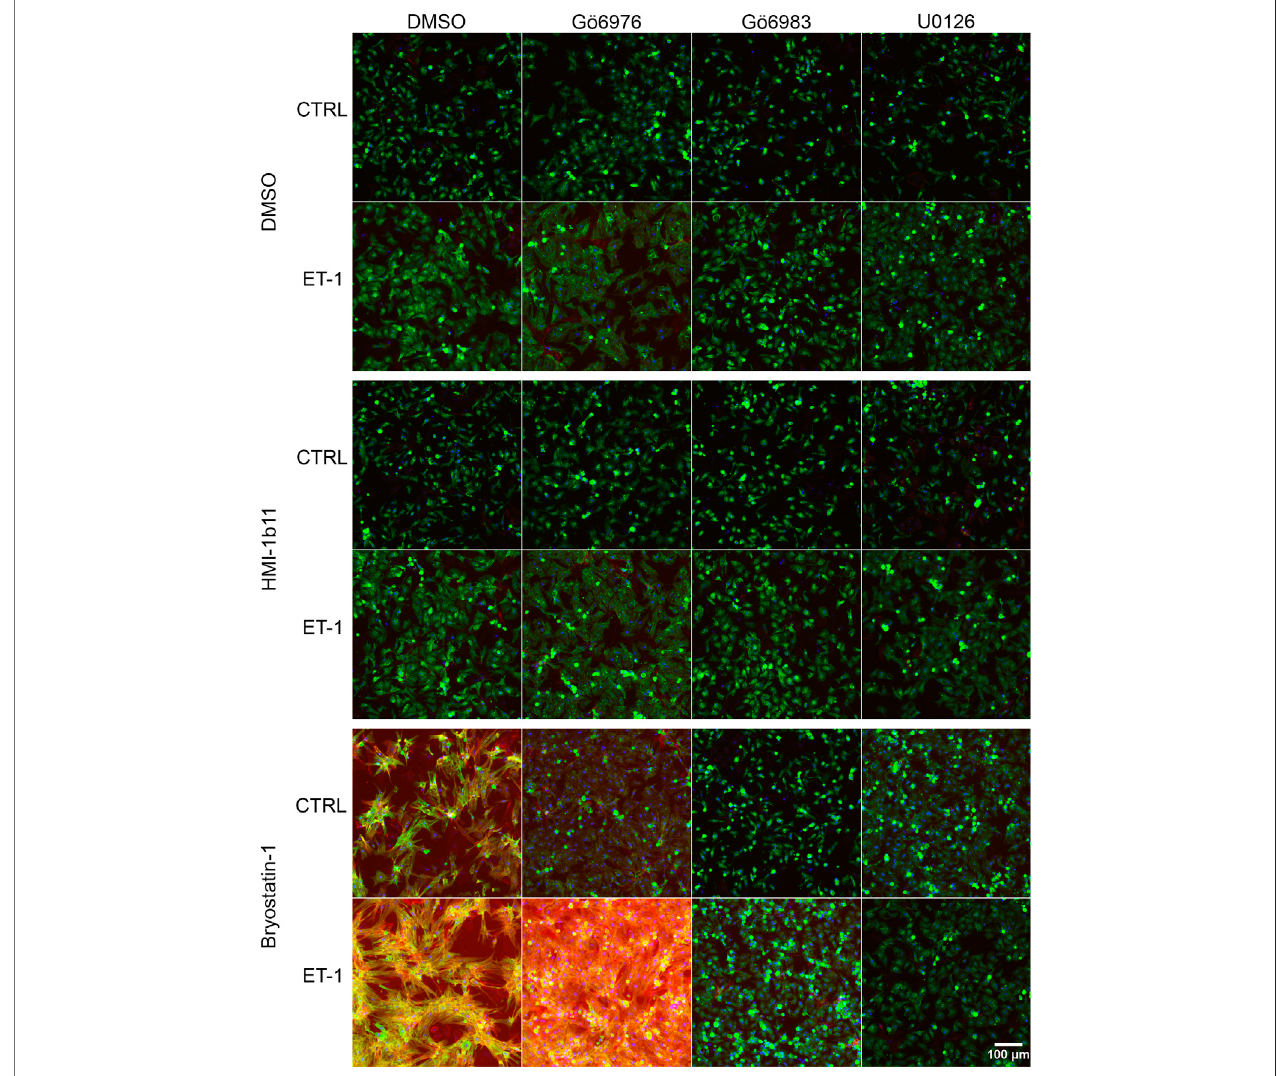
FIGURE 5 | Effects of endothelin-1 (ET-1) and pharmacological PKC modulation on neonatal rat ventricular myocyte (NRVM) morphology. Representative images ofimmuno fl uorescencestainedNRVMstreatedwithPKCactivators(10 µMHMI-1b11and10 nMbryostatin-1),cPKCinhibitor(1 µMGö6976),pan-PKCinhibitor(1 µM Gö6983) and MEK1/2 inhibitor (10 µM U0126) with or without 100 nM ET-1 for 48 h (blue (cid:2) DAPI, green (cid:2) α -actinin, red (cid:2) F-actin). To better visualize morphology, see Supplementary Figure S5 , where brightness and contrast have been adjusted individually for each image.